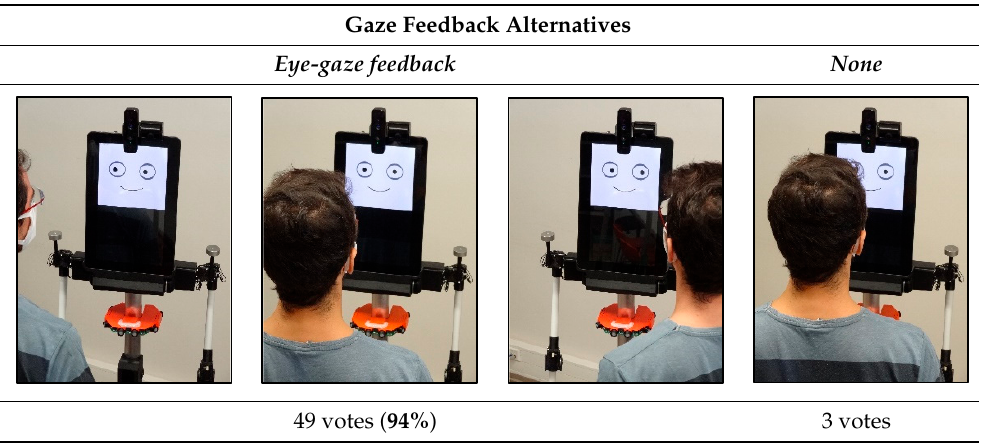
Table 9. Alternatives considered to implement the eye-gaze feedback and votes received.